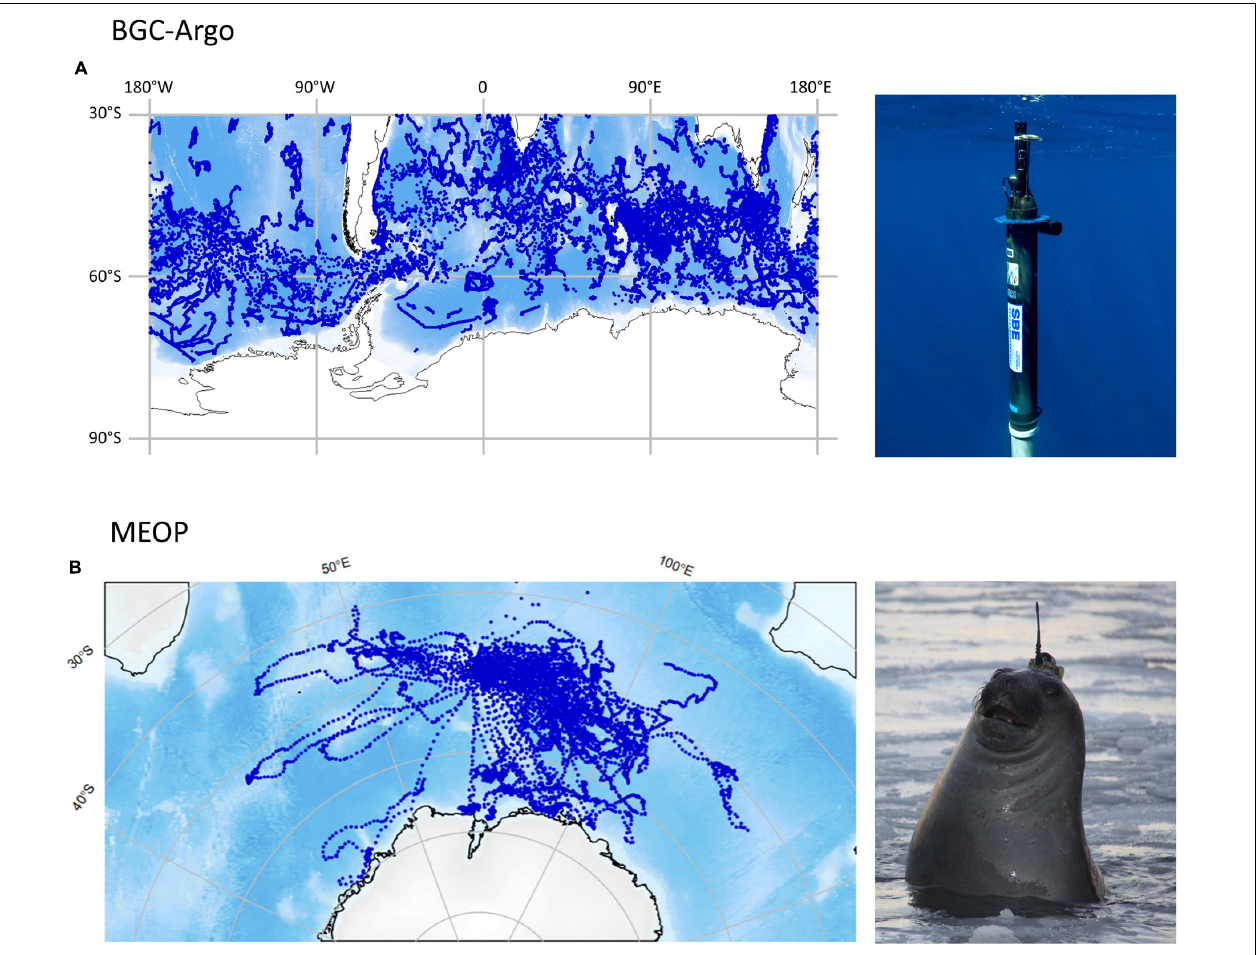
FIGURE 2 | The distribution of available fluorescence-derived chlorophyll- a data collected (blue dots) south of 30 ◦ S overlaid on bathymetry, alongside images of autonomous platforms used in two programs that facilitate large deployments of fluorometers in the Southern Ocean; (A) the biogeochemical Argo (BGC-Argo) and (B) the Marine mammals Exploring the Oceans Pole to pole (MEOP) programs. The distribution plots correspond to BGC-Argo data (produced by Kimberlee Baldry) that is freely available and MEOP data (produced by Professor Mark Hindell) available from the Integrated Marine Observing System through program leaders (Professor Mark Hindell and Dr. Christophe Guinet). Data shown was that available on the 28/03/2020. Credits for instrumentation images go to Christoph Gerigk at© Sea-Bird Electronics for BGC-Argo and Clive McMahon for